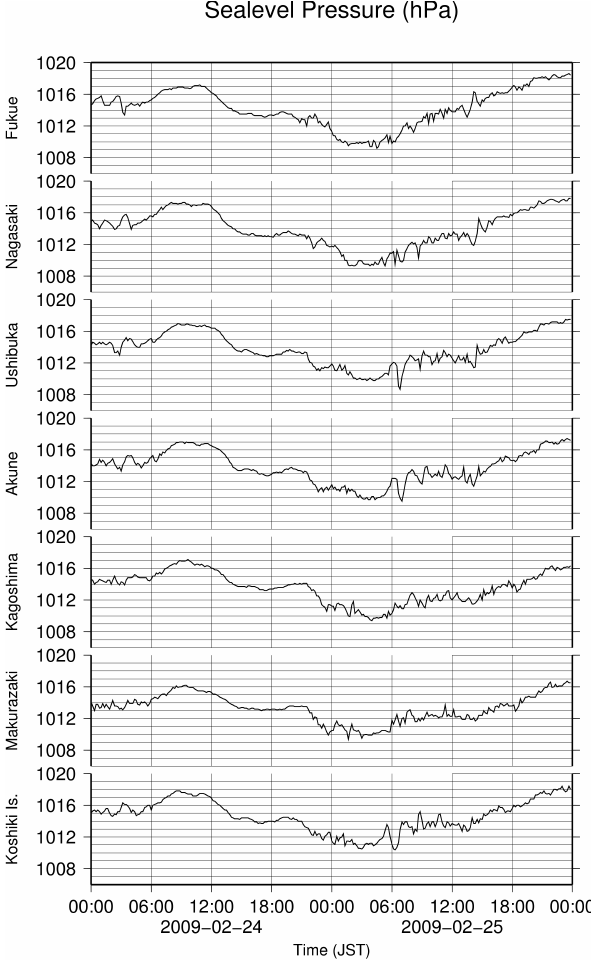
Fig. 6. Sea-level pressure observed in western Kyushu. All obser- vations were by the Japan Meteorological Agency except for those at Kamikoshiki, which were by the Kamikoshiki Island branch of the Satsuma Sendai City Office.